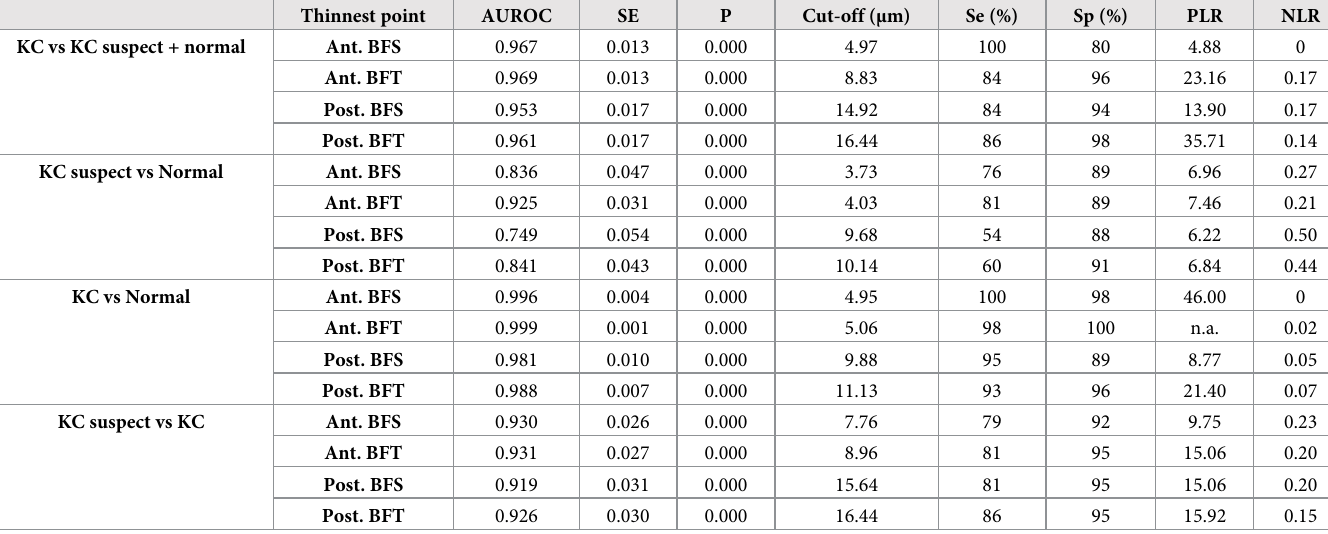
Table 3. The cut-off point, specificity, and sensitivity values identified by the different reference